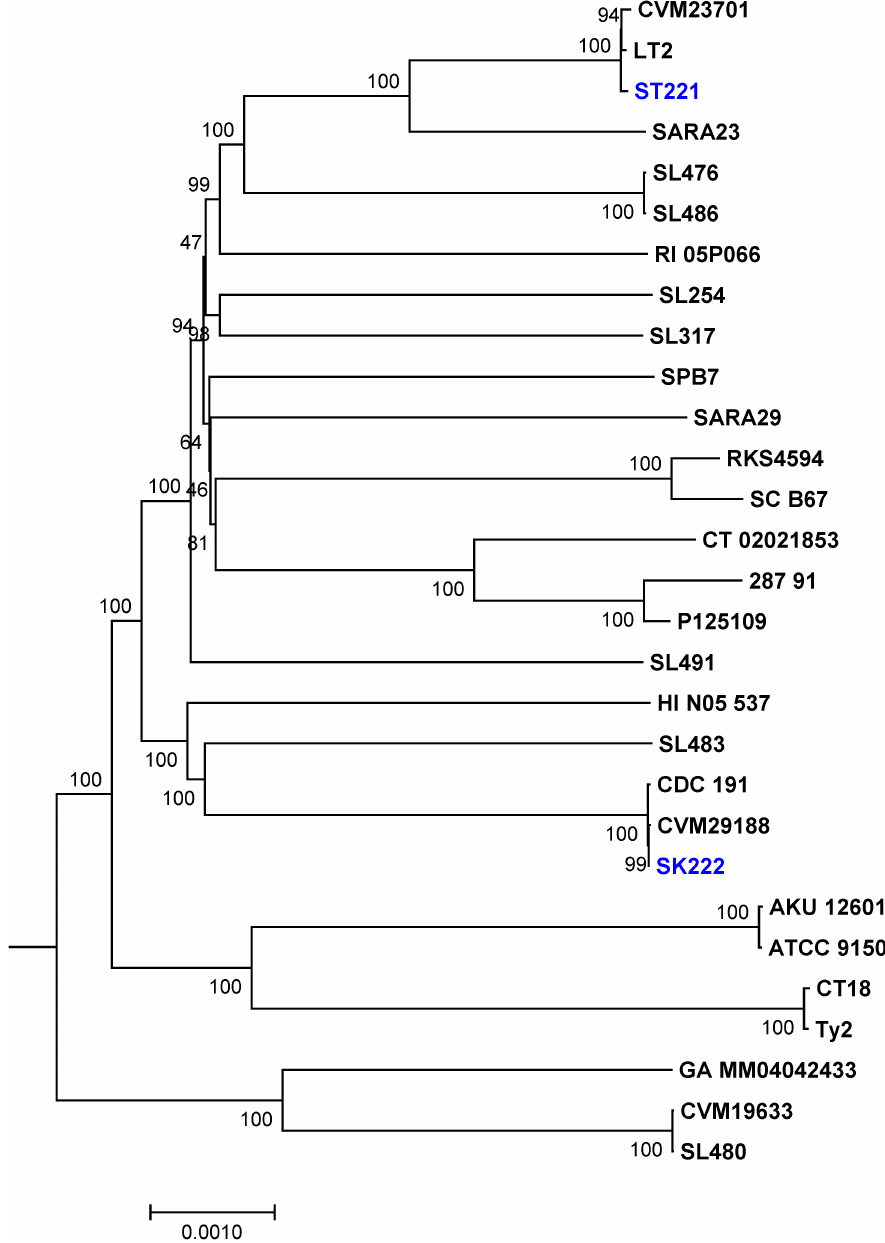
Fig 1. The rooted phylogenetic tree based on core genome of S . enterica . Neighbor-joiningtree was constructed based on homologous alignment of 1,185 conservedORFs (1,113,790 bp). The tree was rooted with Salmonella enterica subsp. arizonaeserovar 62:z4,z23:- str. RSK2980. Bar represents 0.001 substitutionsper site.